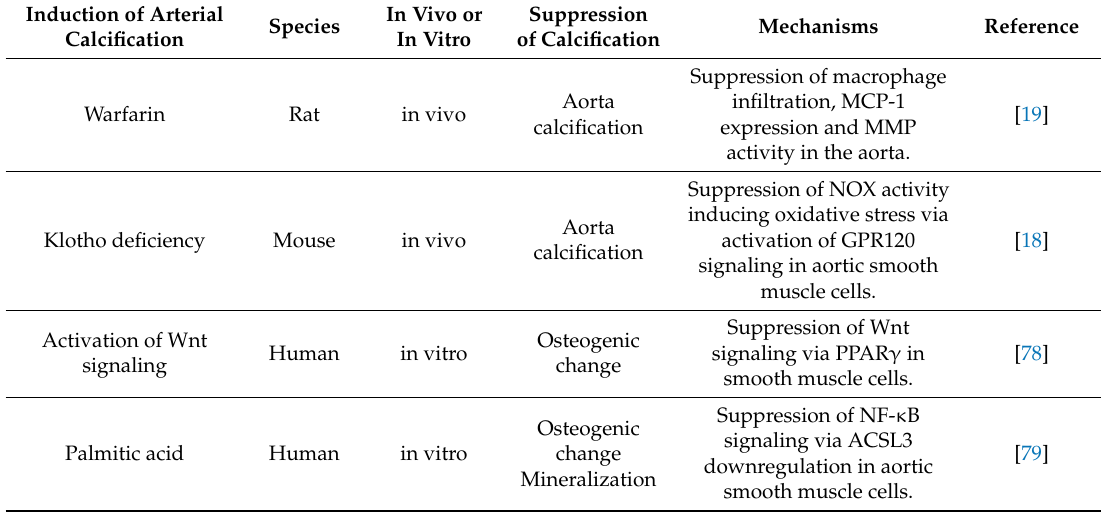
Table 1. E ff ects of Eicosapentaenoic Acid (EPA) on Arterial Calcification in Experimental